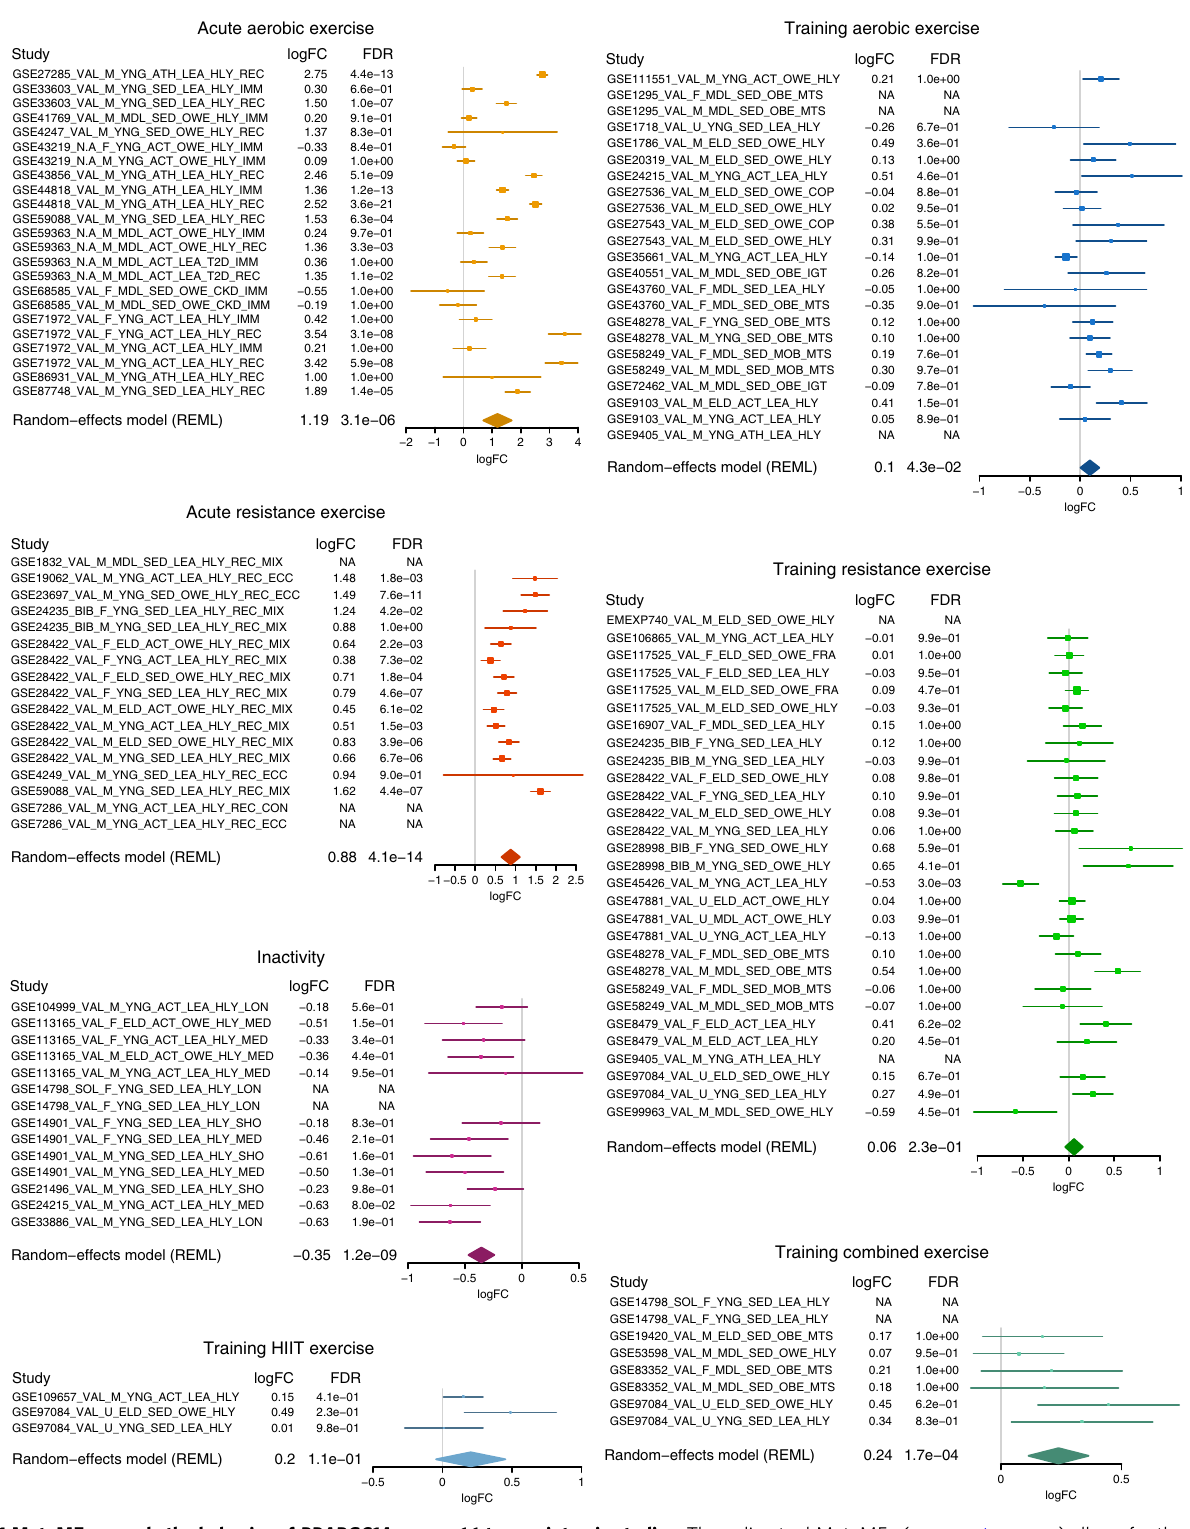
Fig. 1 MetaMEx reveals the behavior of PPARGC1A across 66 transcriptomic studies. The online tool MetaMEx (www.metamex.eu) allows for the quick interrogation of all published exercise and inactivity studies for a single gene. The analysis provides annotations of each study with respect to skeletal muscle type obtained, sex, age, fi tness, weight, and metabolic status of the participants studied. The forest plot of individual statistics (fold-change, FDR, 95% con fi dence intervals), as well as the meta-analysis score is provided. In the case of HIIT training and combined exercise training protocols, the number of studies is insuf fi cient to calculate meaningful meta-analysis statistics. NA: not